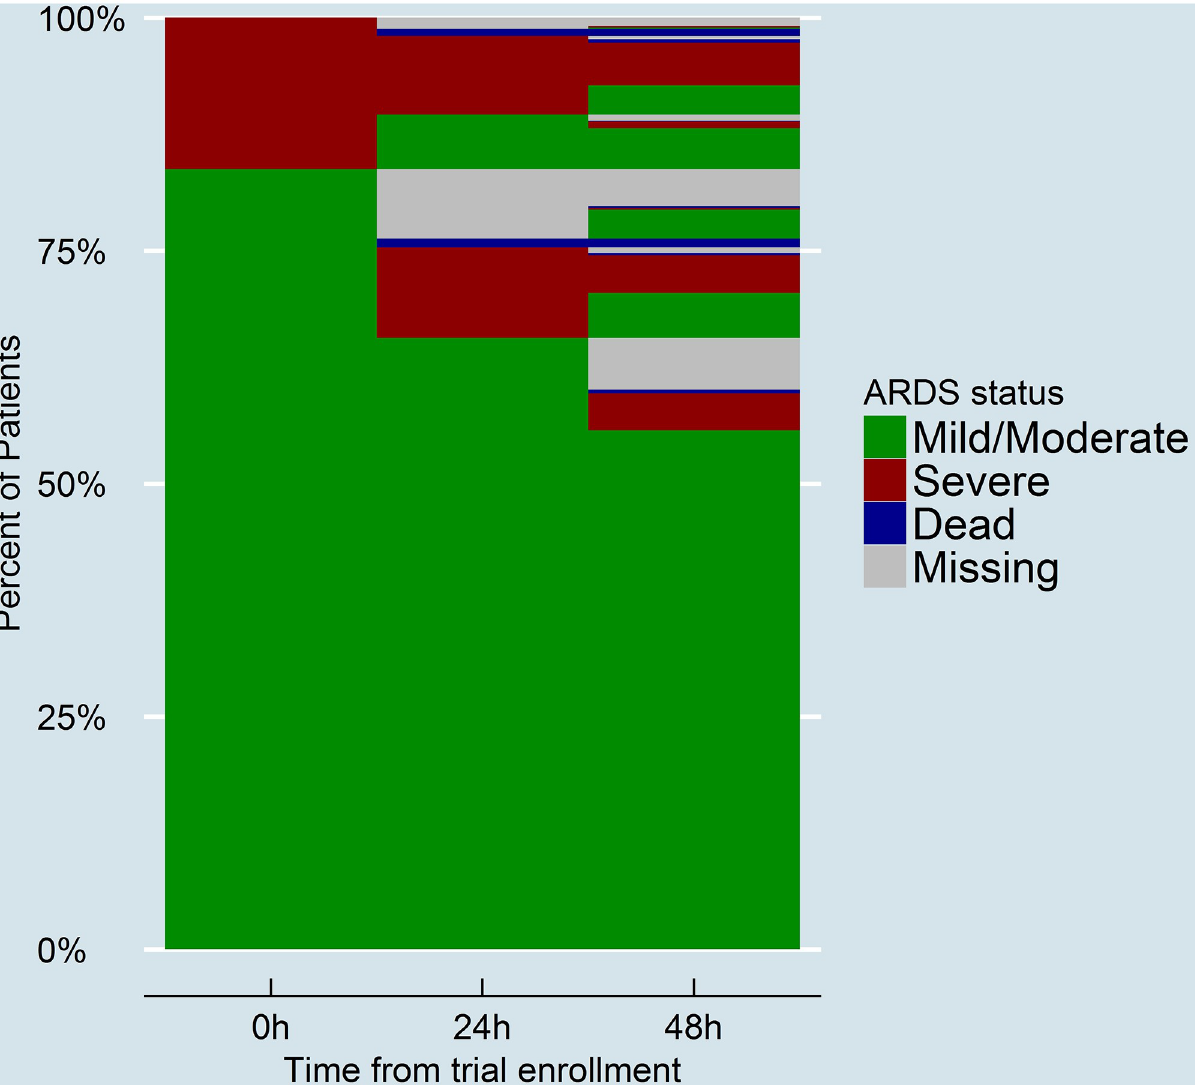
Fig 1. Lasagna plot depicting the trajectory of hypoxemia of each individual patient during the first two study days after trial enrollment. On the second study day, some patients that initially had mild/moderate ARDS (shown as green) progressed to persistent severe ARDS (shown in red). Some patients with an initial presentation of severe ARDS (red) continued to have severe ARDS on the second study day.